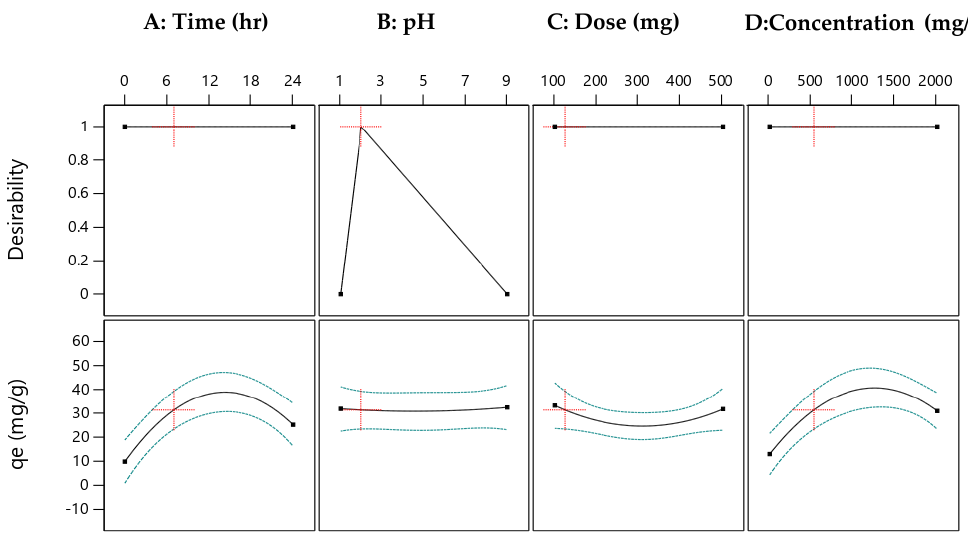
Figure 15. Desirability ramps of Cu(II) removal efficiency onto H + Dowex-M4195 chelating resin from the selected quadratic model at a low pH.